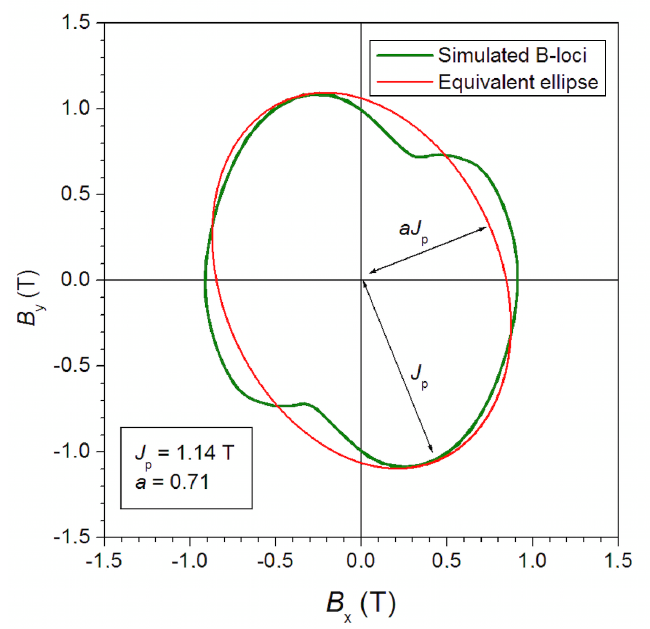
Figure 11. B -locus at a given point within the iron pole: computed cycle and equivalent ellipsoidal